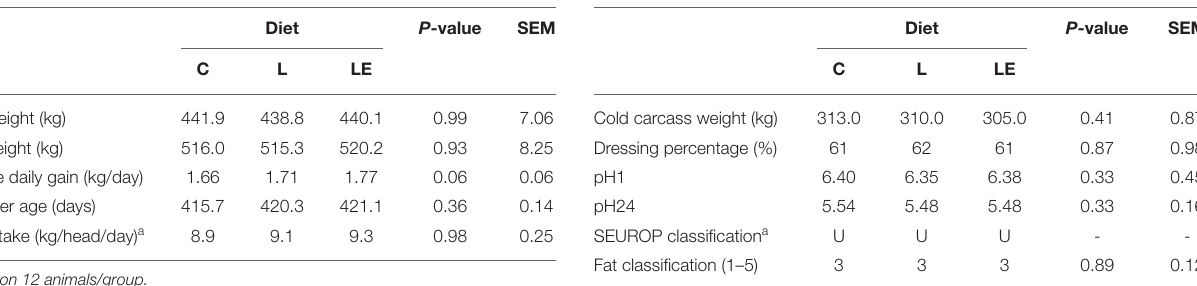
TABLE 2 | Effect of the experimental diets C (Control), L (Linseed), and LE (linseed + vitamin E) on Marchigiana beef in vivo performance.